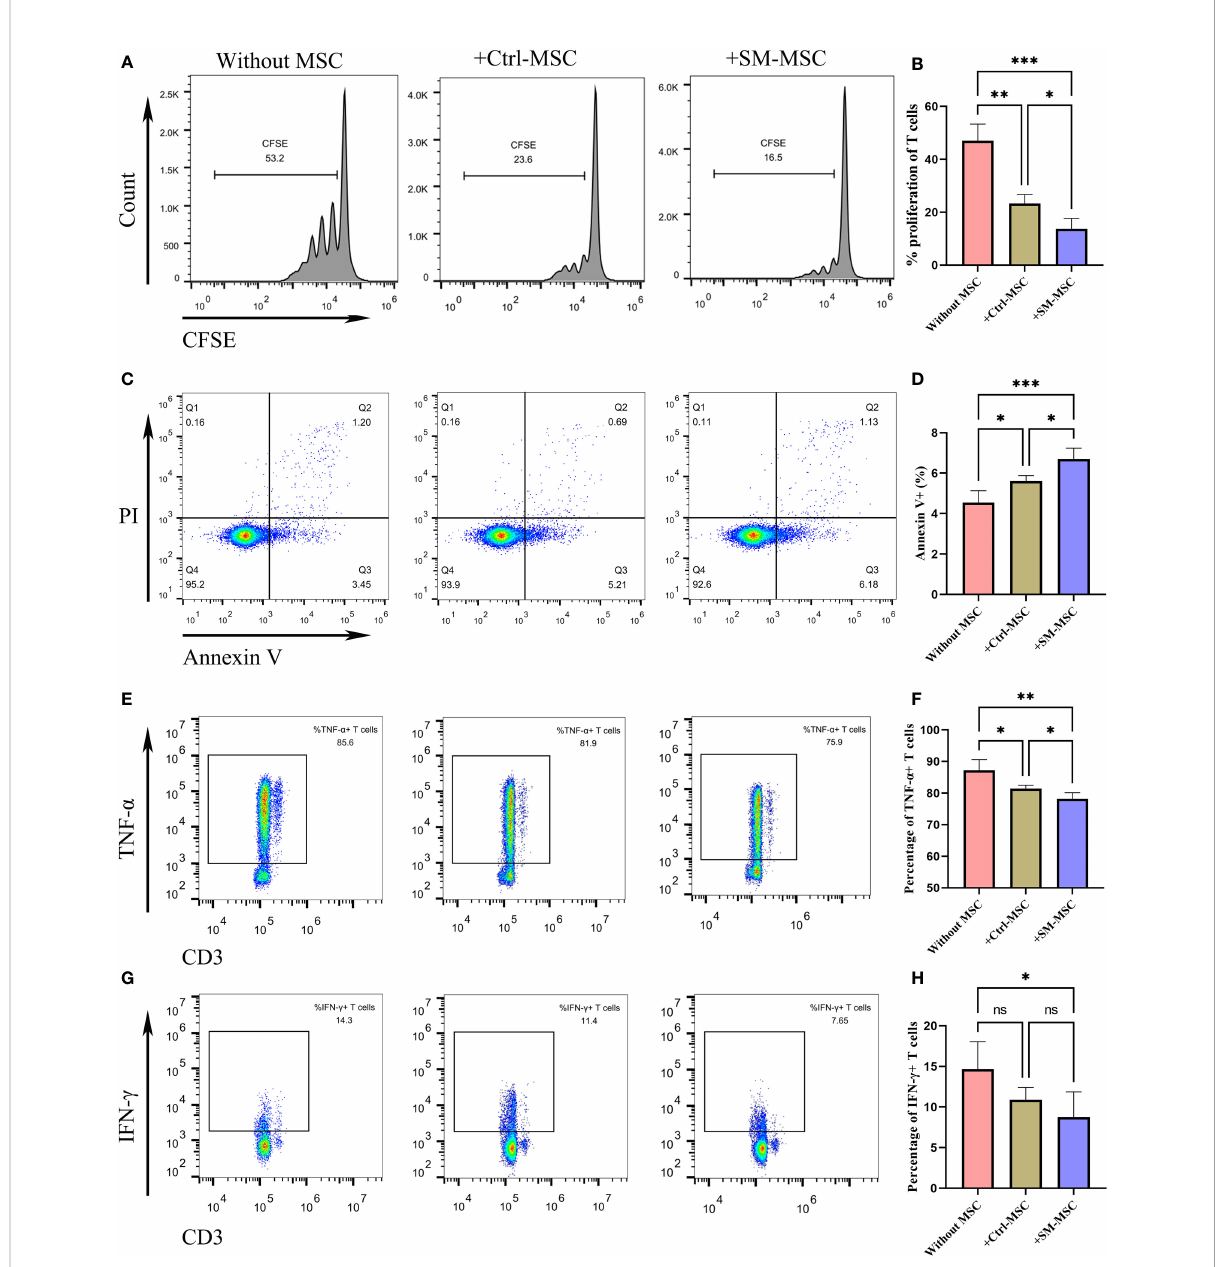
FIGURE 2 Comparison of immunosuppressive effects on activated T cells. (A, B) The proliferation levels of T cells were analyzed by CFSE staining, n=4 per group. (C, D) T cells were analyzed for apoptosis using PI & Annexin V staining, n = 5 per group. The expression levels of TNF- a (E, F) and IFN- g (G, H) were analyzed by fl ow cytometry, n = 6 per group. Data are shown as mean ± SD, *P < 0.05, **P < 0.01, ***P < 0.001 and ns means not signi fi